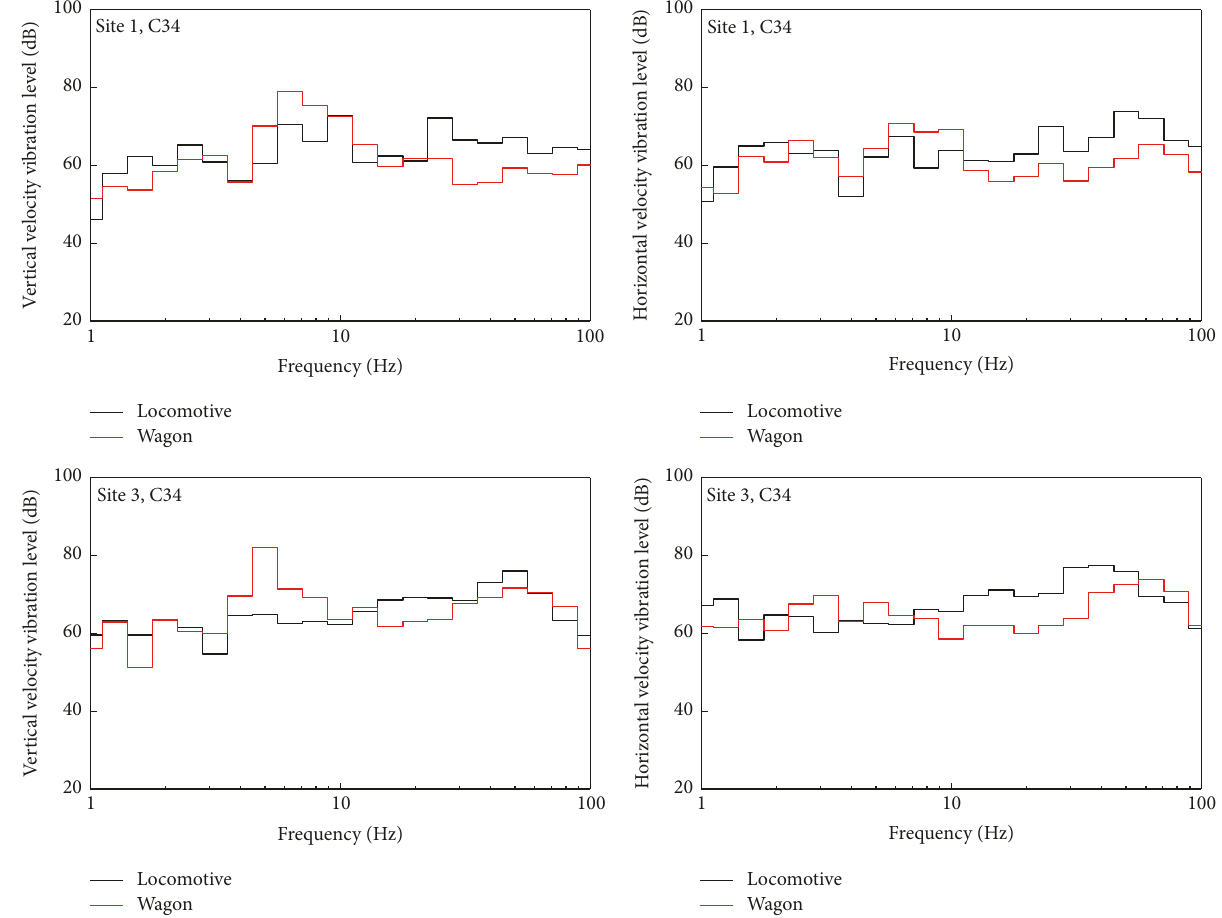
Figure 12: Comparison of the one-third octave band spectra induced by locomotive and wagon.